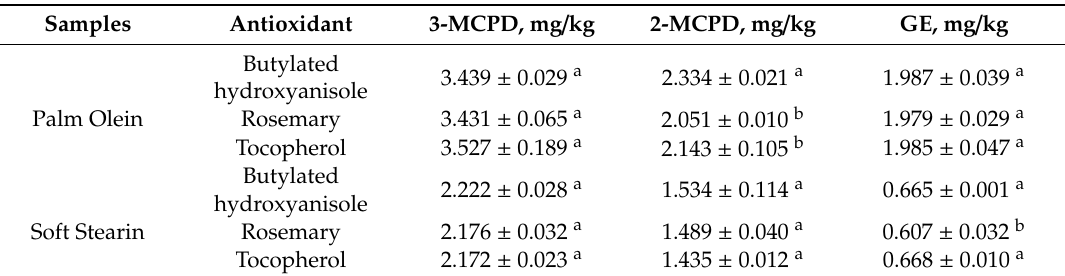
Table 2. E ff ects of di ff erent antioxidants (200 ppm) on the content of 2-monochloropropandiol (MCPD), 3-MCPD and glycidyl ester (GE) on the fats portion extracted from cake baked at 160 ◦ C for 20 min with di ff erent shortenings